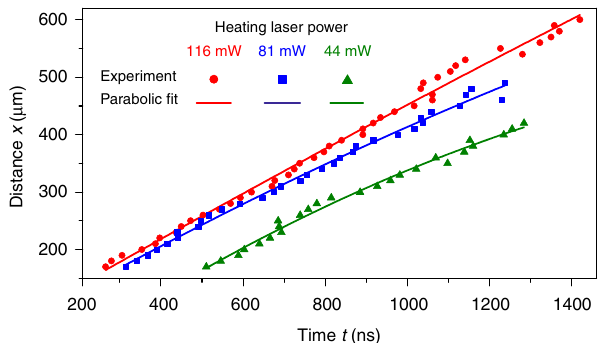
Fig. 4 Space-time diagrams of the second sound pulses. Position x of the propagating BEC hump is shown vs time t for different laser powers P L together with parabolic fi ts, from which we estimate the initial c s ( t 0 ) and fi nal pulse velocities c t s ( max ) presented in Table 1 NATURE COMMUNICATIONS| (2019) 10:2460